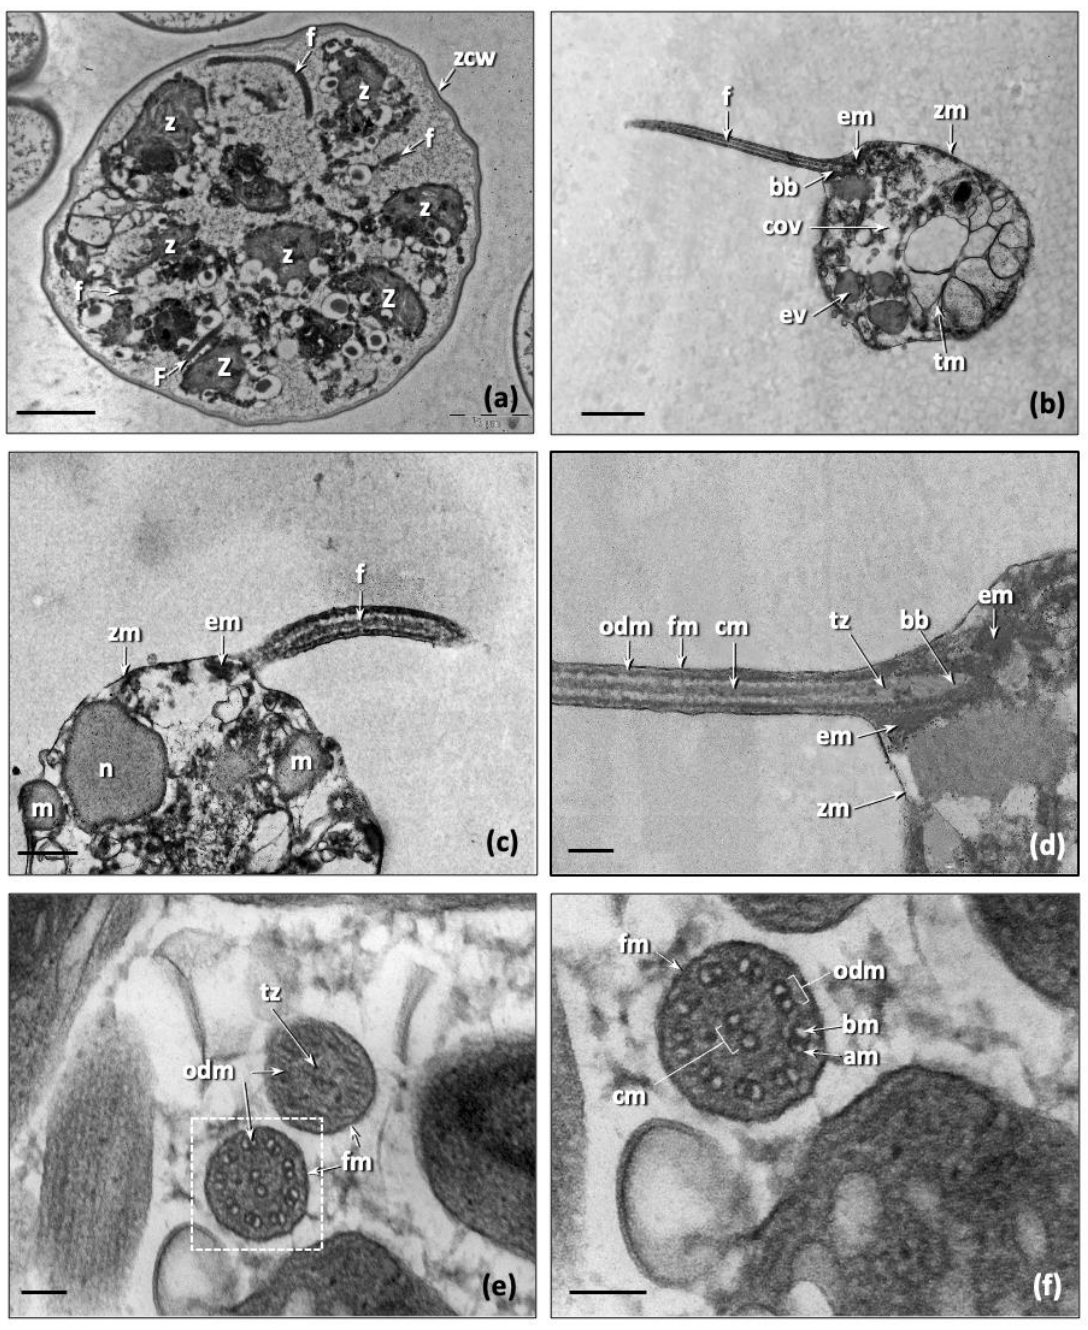
Figure 3. The zoospores of Trebouxia lynnae sp. nov.: ( a ) zoosporangium with several zoospores; ( b , c ) longitudinal section of a zoospore; ( d ) longitudinal view of the flagella insertion in the zoospore; ( e ) cross section of two flagella in a young zoospore, one in the filament zone and another in the transition zone; ( f ) detail of the filament zone flagella. Abbreviations: am (microtubule a), bb (basal body), bm (microtubule b), cm (central microtubules), cov (contractile vesicle), em (electrodense material), ev (electrondense vesicle), f (flagellum), fm (flagellum membrane), m (mitochondria), n (nucleus), odm (outer microtubules doublet), tm (thylakoidal membrane), tr (transition region), tz (transition zone), zcw (zoosporangium cell wall), z (zoospore), zm (zoospore membrane). White arrows point to the peculiar ultrastructures identified by the abbreviations. Scale bars: ( a ) = 2 μm, ( b ) = 1 μm, ( c ) = 400 nm, ( d ) = 200 nm, ( e , f ) = 100 nm. Reference strain: ASUV 44 .